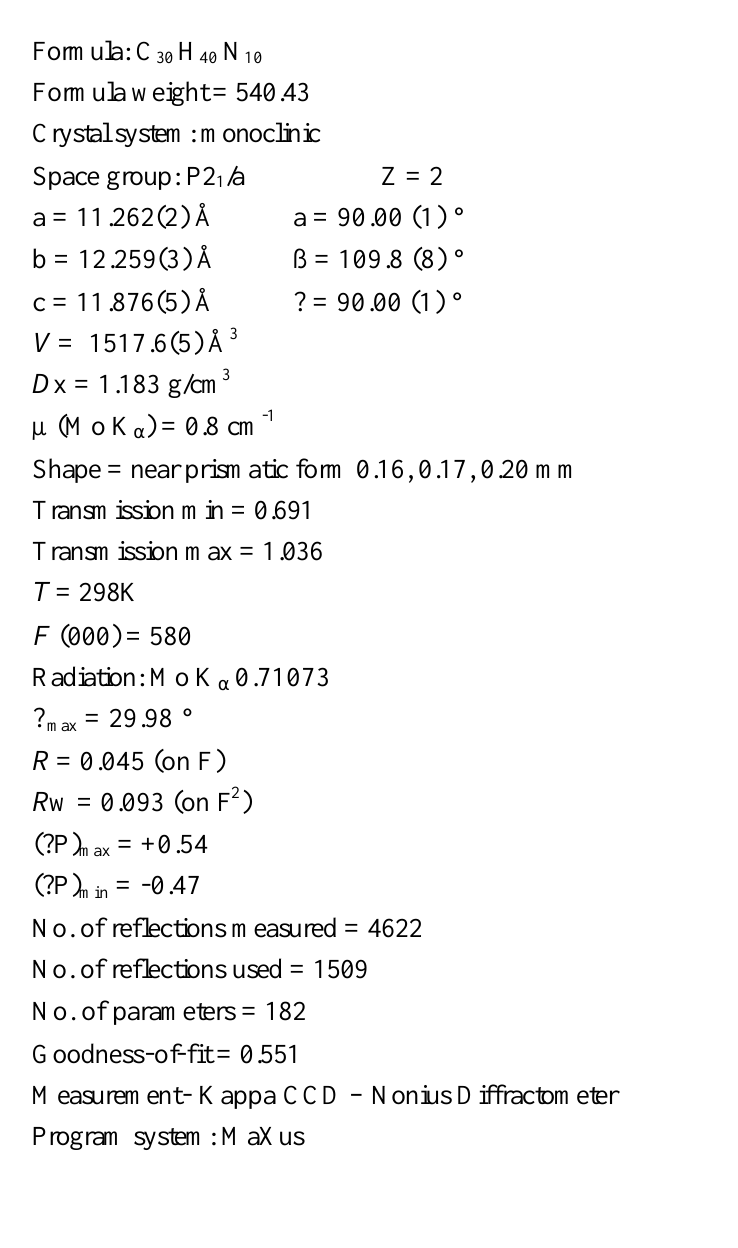
Table 1 Crystal and experimental data of bis -tripod